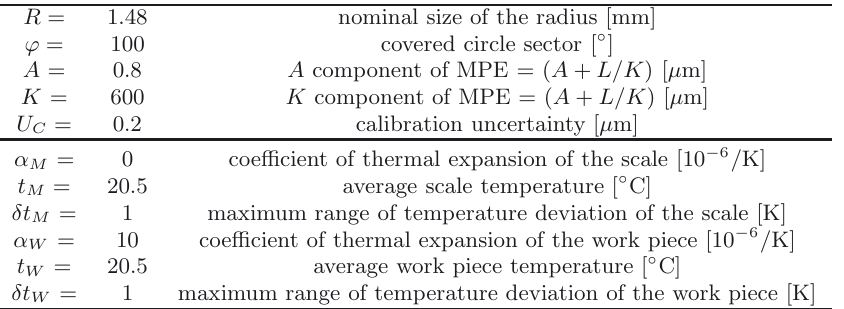
Table 2. Determined measurement conditions.